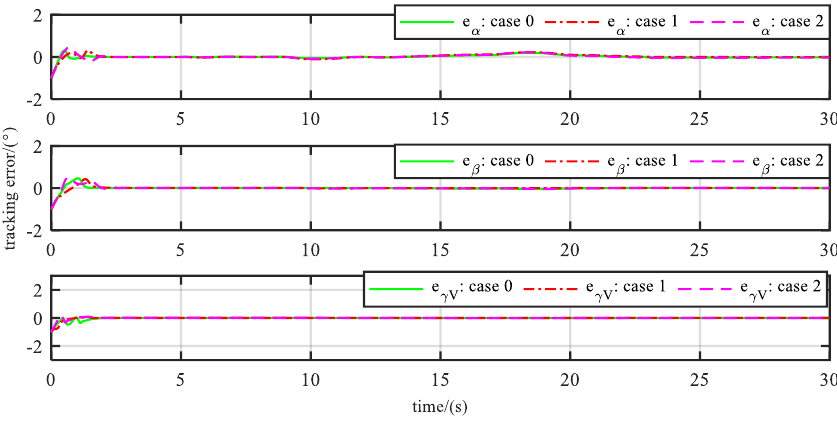
Figure 9. Tracking errors under three cases. Table 2. Tracking errors of attack angle at different time periods.